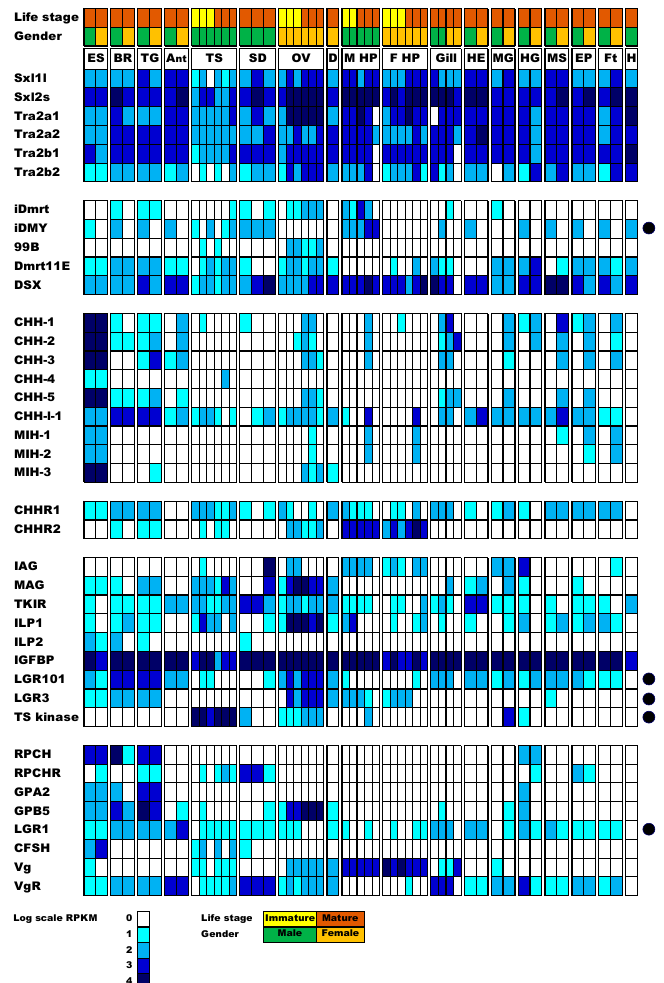
Figure 1. Expression of key sexual development transcripts across multiple tissues on the ornate spiny lobster Panulirus ornatus . The expression of key transcripts involved in sexual development was calculated as reads per kilobase per million reads (RPKM) in RNA-Seq libraries of multiple P. ornatus tissues. Log-transformed expression is represented by gradient color shading. Tissues from left to right: ES—eyestalk (male, female); BR—brain (male, female); TG—thoracic ganglia (male, female); AnG—antennal gland (male, female); TS—testis (3 × immature, 3 × mature males); SD—sperm duct